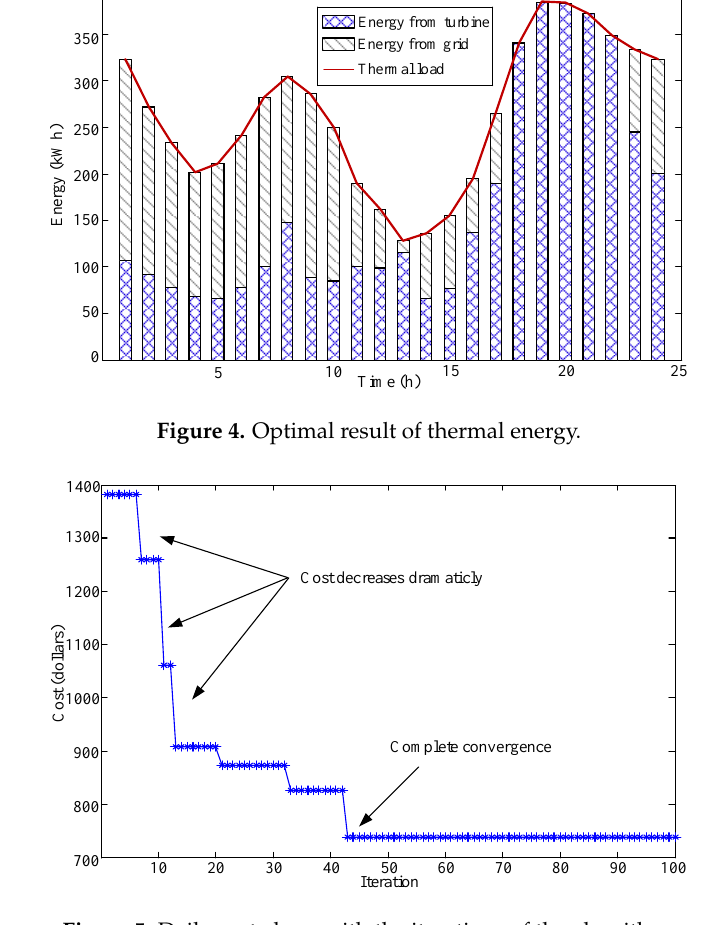
Figure 5. Daily cost along with the iterations of the algorithm. Table 2. Daily cost of each prosumer with BSV